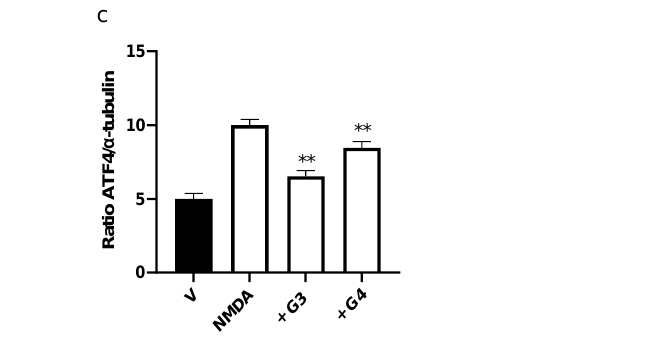
Figure 6. Quantification of the effect of phosphorous dendrimers on NMDA-induced changes in ER ER stress proteins. Neurons were treated with vehicle (V) or with 10 µ M of G3 or G4 phosphorous